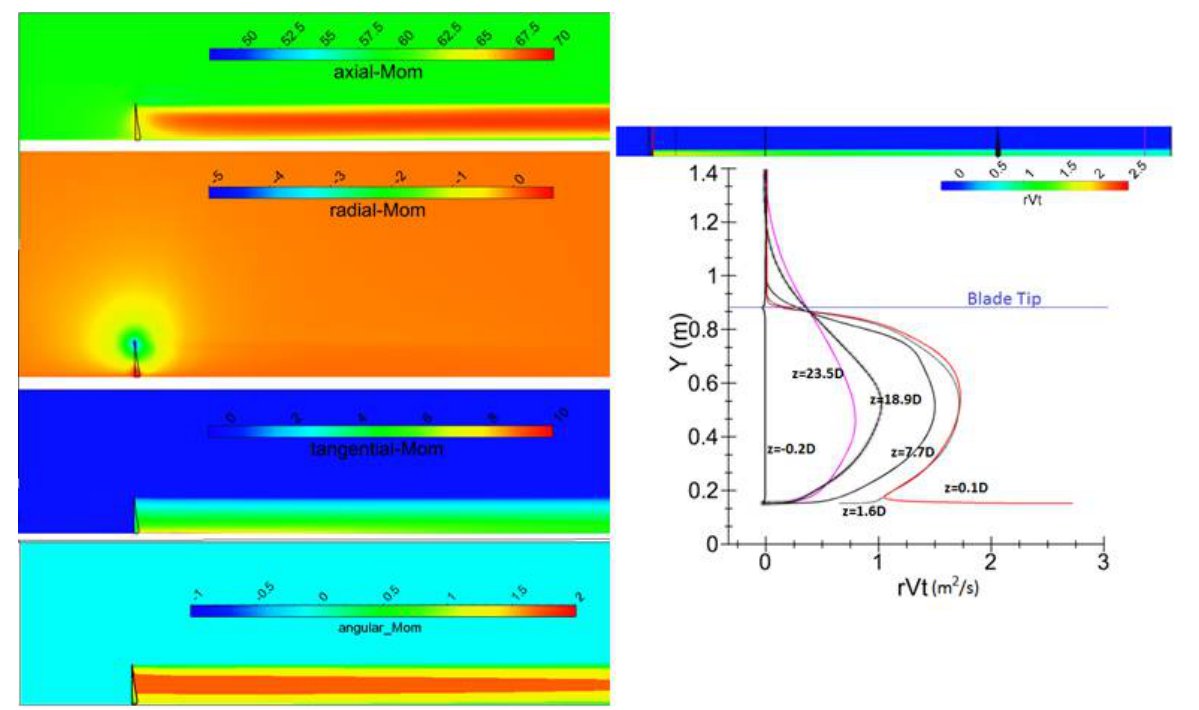
Figure 17. Mass averaged axial, radial, tangential and angular momentum (Mom) contours up to 8D downstream for 4X domain, showing the biggest contributor for entropy rise is axial momentum. Swirl distributions at downstream locations are also shown.